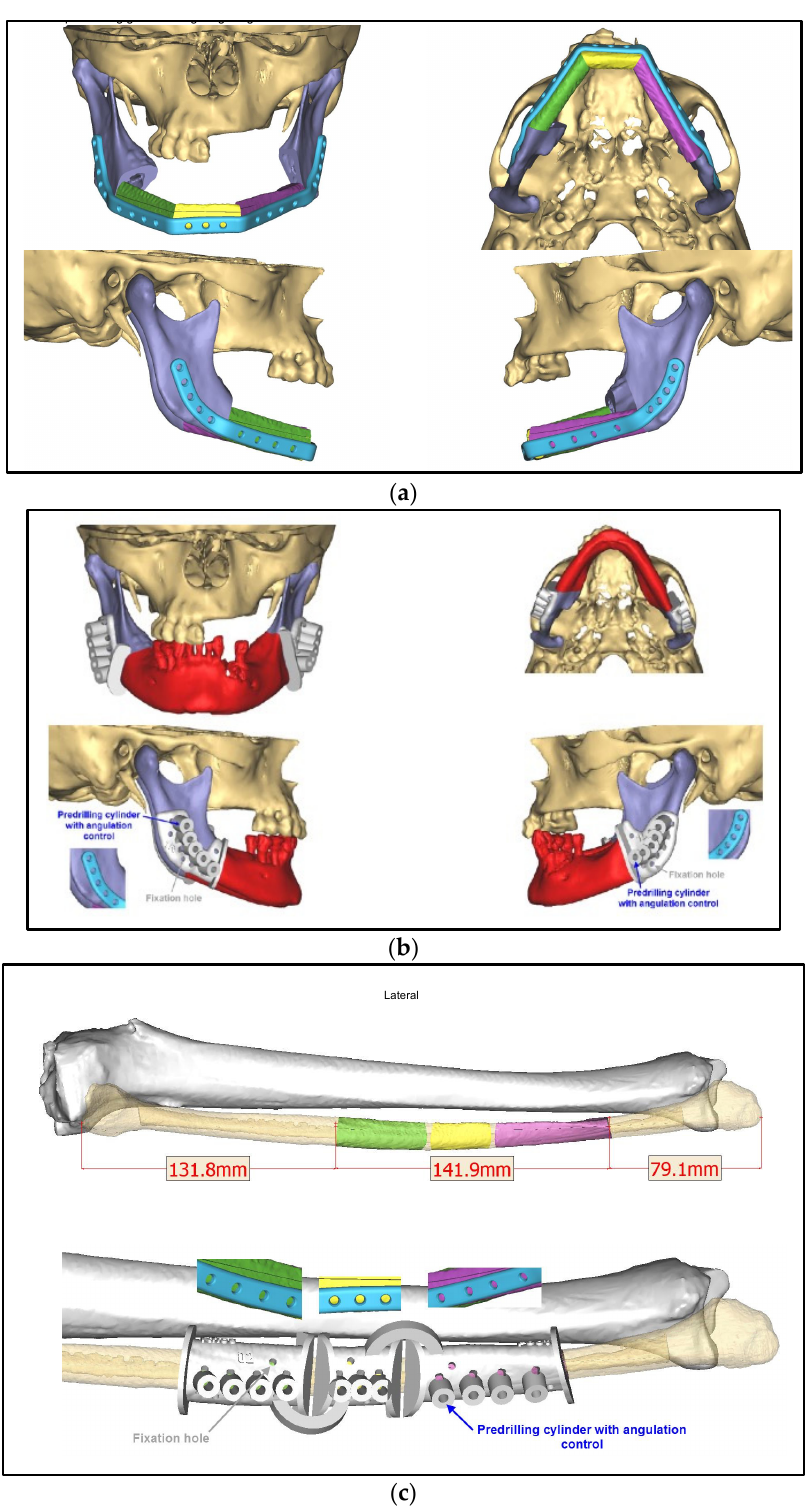
Figure 6. CAD/CAM-guided planning of the resection and reconstruction of the mandible using a free fibular flap: ( a ) planned postoperative situation after resection and reconstruction with three fibula segments and patient-specific plate; ( b ) cutting-/drill-guides for resection of the mandible (red) and pre-drilling of the holes for fixation of the patient-specific reconstruction plate ( c ) patient’s right fibula with colored osteotomy segments for the planned reconstruction of the mandible; surgical guides for osteotomy of the fibula.